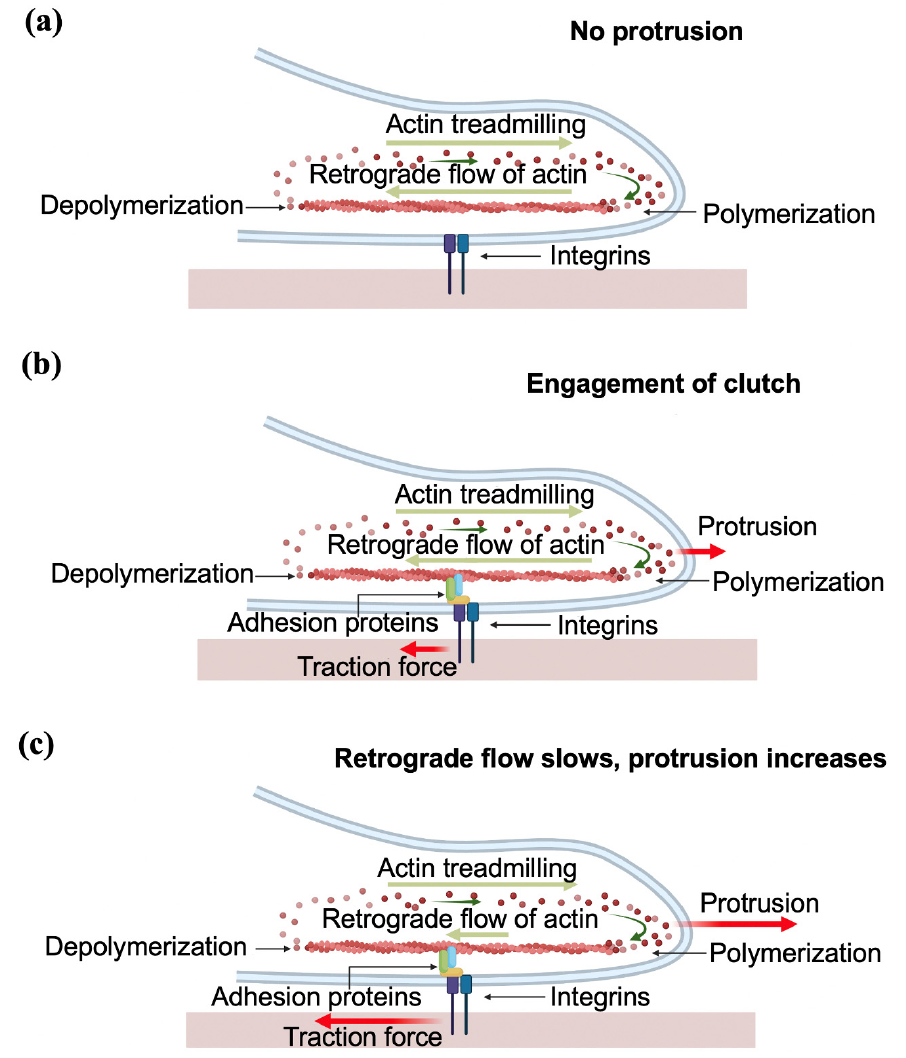
Figure 10. Schematic representation of axonal outgrowth, showing the stage of protrusion. ( a ) When the molecular clutch is not engaged, the F-actin treadmilling and retrograde flow is balanced, and there is no traction or protrusion; ( b ) the clutch is engaged through adhesion proteins; ( c ) the engagement of the clutch results in the attenuation of retrograde actin flow, and in an increase of F-actin polymerization at the leading edge, which causes the generation of traction forces and the protrusion of the growth cone.